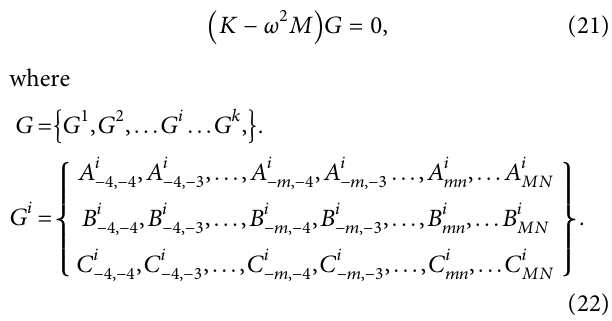
Table 1: The first five natural frequencies Ω � ω b 2 and N